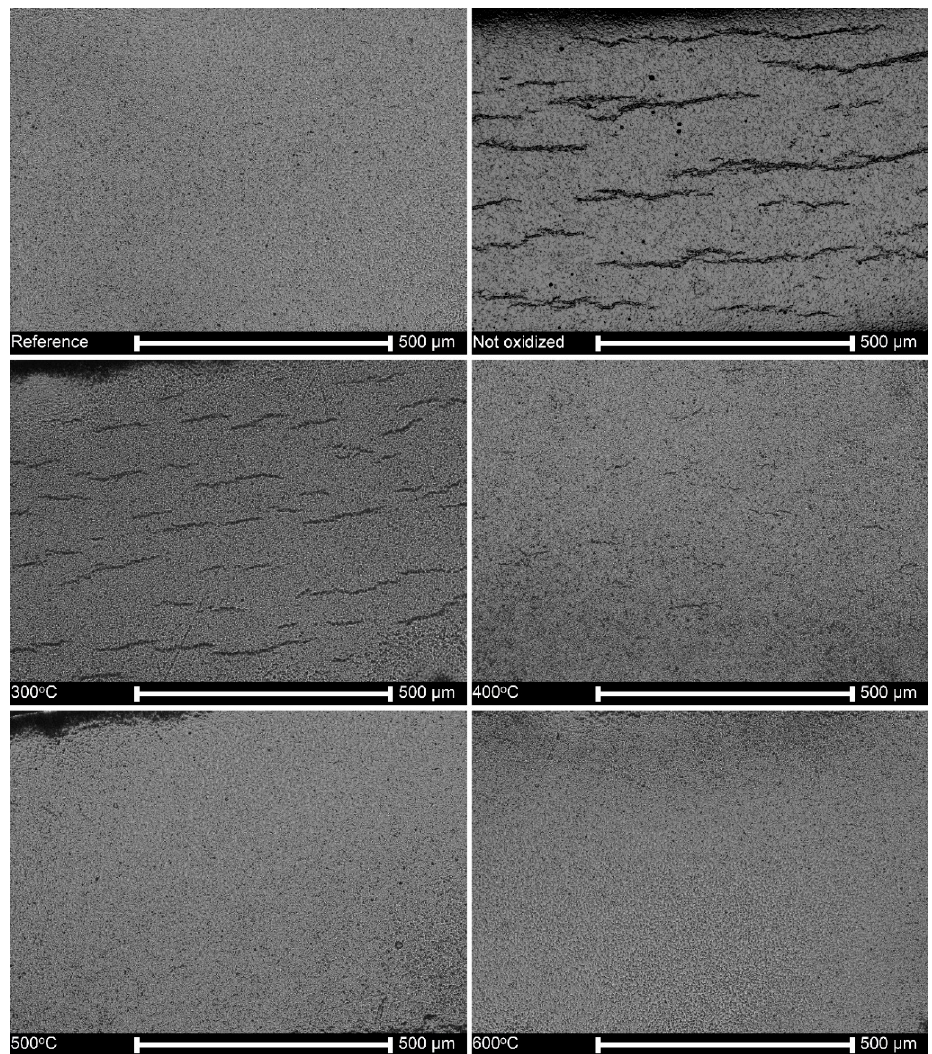
Figure 7. Cross-sections of specimens oxidized at different temperatures and hydrogen-charged at a constant current density of 80 mA/cm 2 for 3 days and homogenized at 400 °C for 4 h.